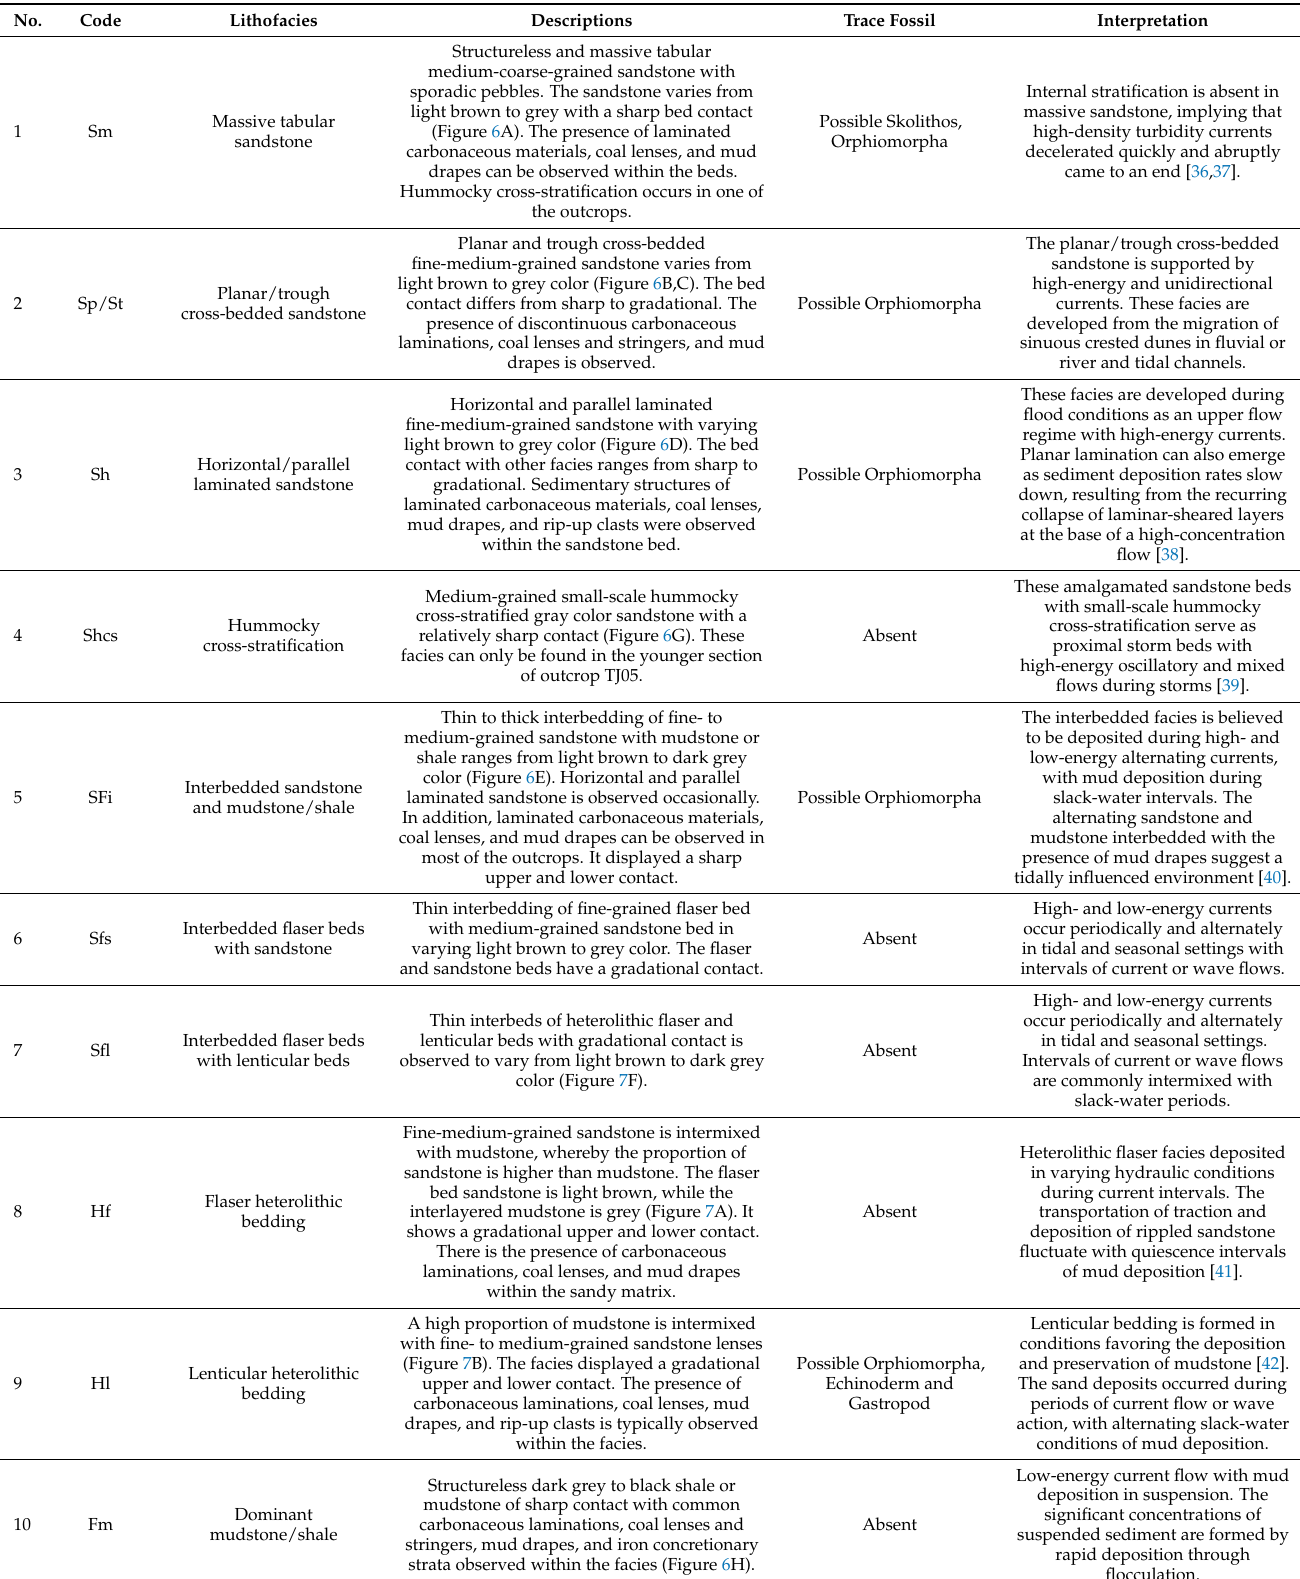
Table 1. The twelve (12) classified lithofacies in the Tanjong Formation, southeast